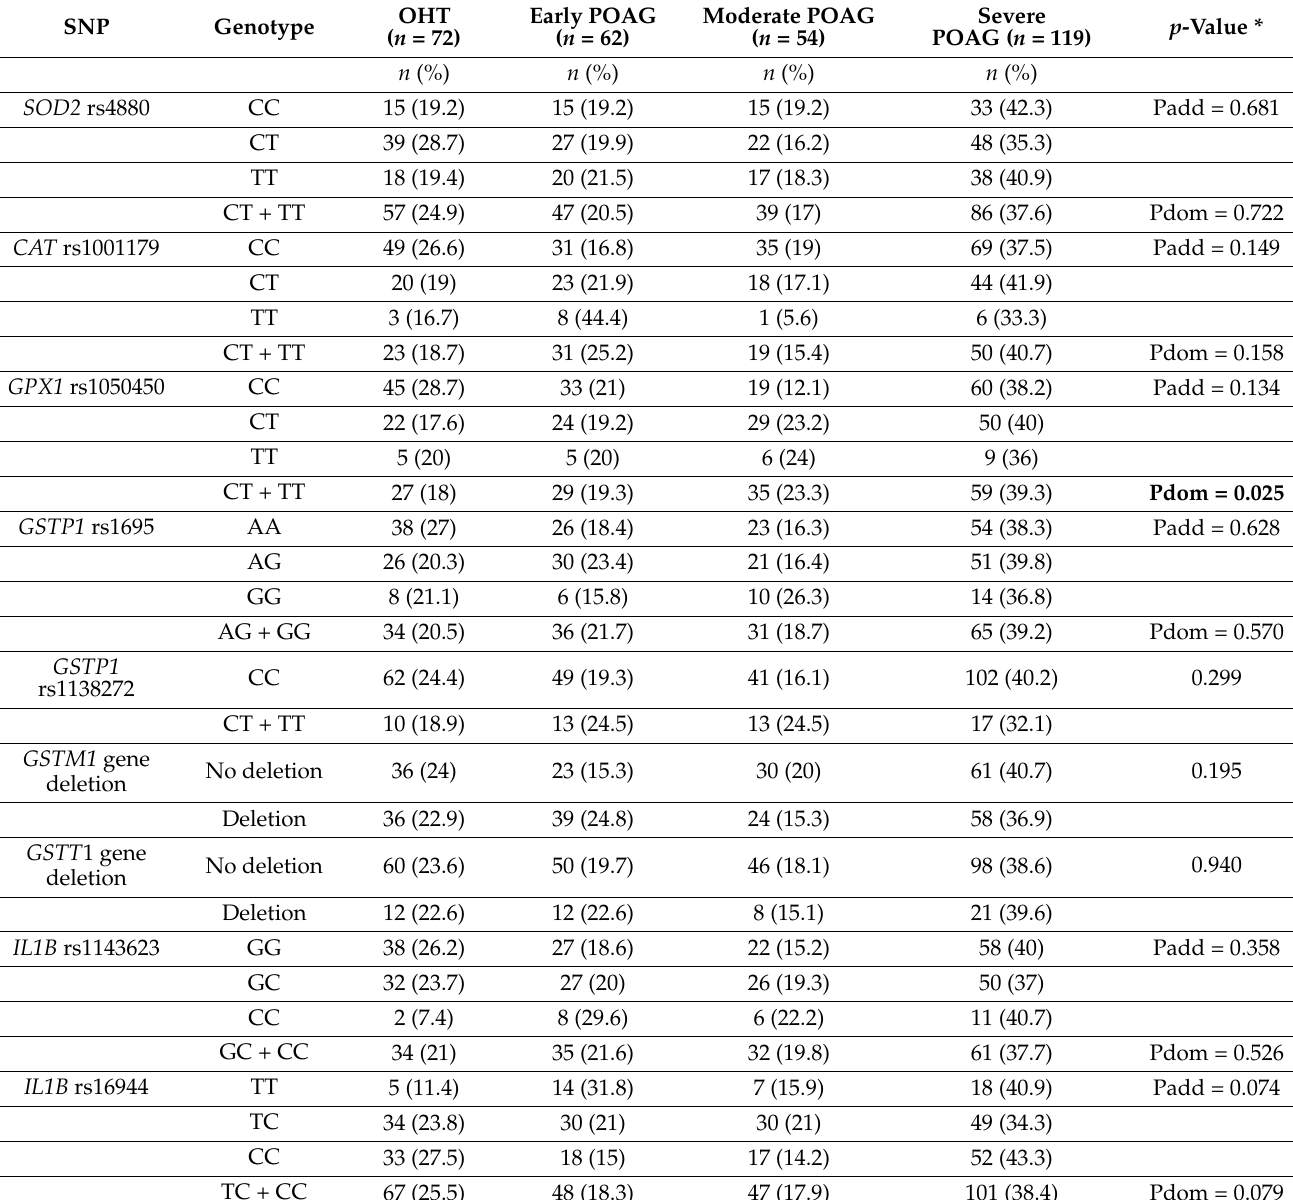
Table 4. Association of selected polymorphisms with OHT and POAG